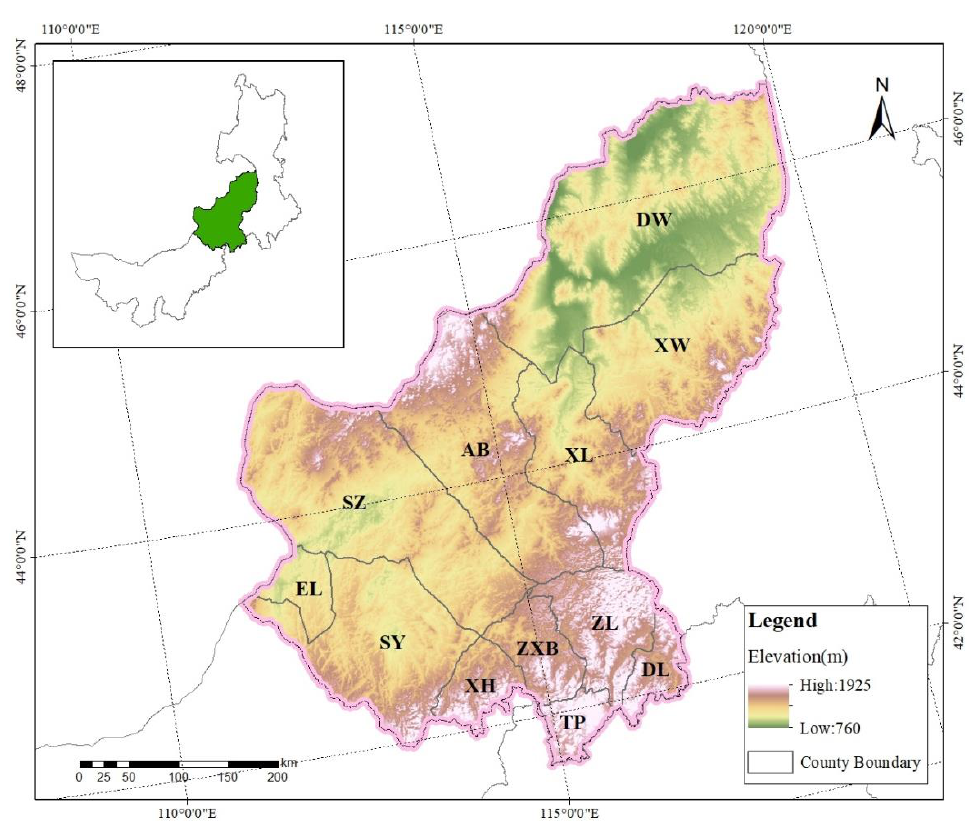
Figure 1. Location and elevation of the Xilingol (DW is Dongwuzhumuqin Banner, XW is Xiwuzhu- muqin Banner, XL is Xilinhot, AB is Abaga Banner, SZ is Sunitezuo Banner, SY is Suniteyou Banner, EL is Erlianhot, XH is Xianghuang Banner, ZXB is Zhengxiangbai Banner, ZL is Zhenglan Banner, TP is Taipusi Banner, DL is Duolun County).